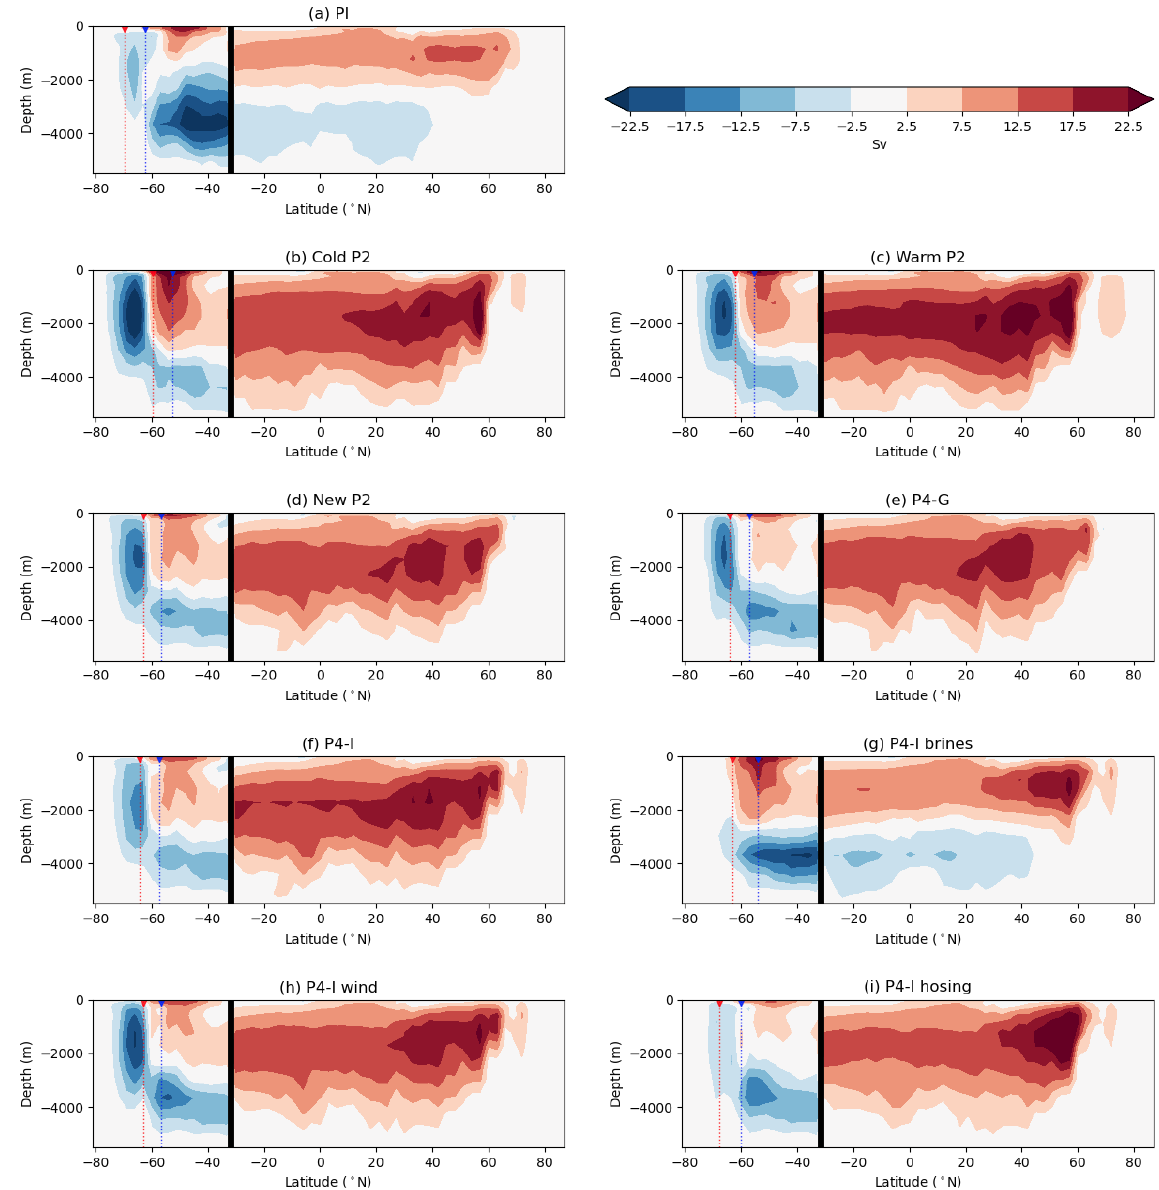
Figure 7. Streamfunctions (Sv) in the Atlantic (north of 32 ◦ S) and Southern Ocean basins (south of 32 ◦ S). The vertical black line represents the limit between these two basins, chosen at 32 ◦ S. The thin dotted lines show the latitude of the average sea-ice edge in austral summer (red) and winter (blue) for each